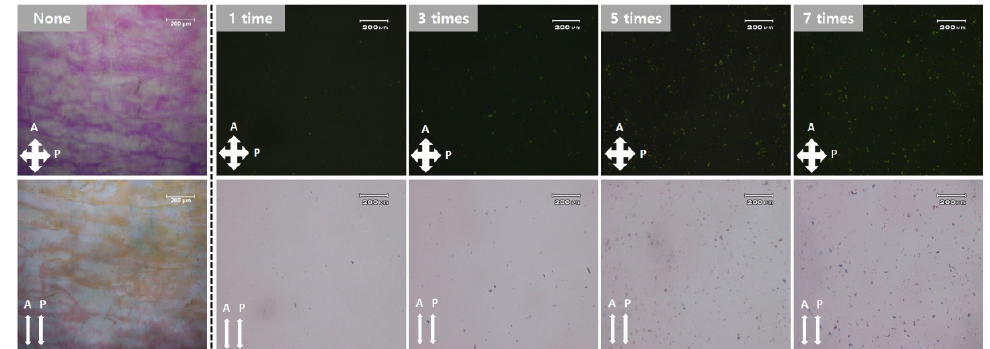
Figure 2. Photomicrographs of AP LC cells with solution-derived ZnO films as a function of rubbing iteration number. A and P represent the analyzer and polarizer axes, respectively.